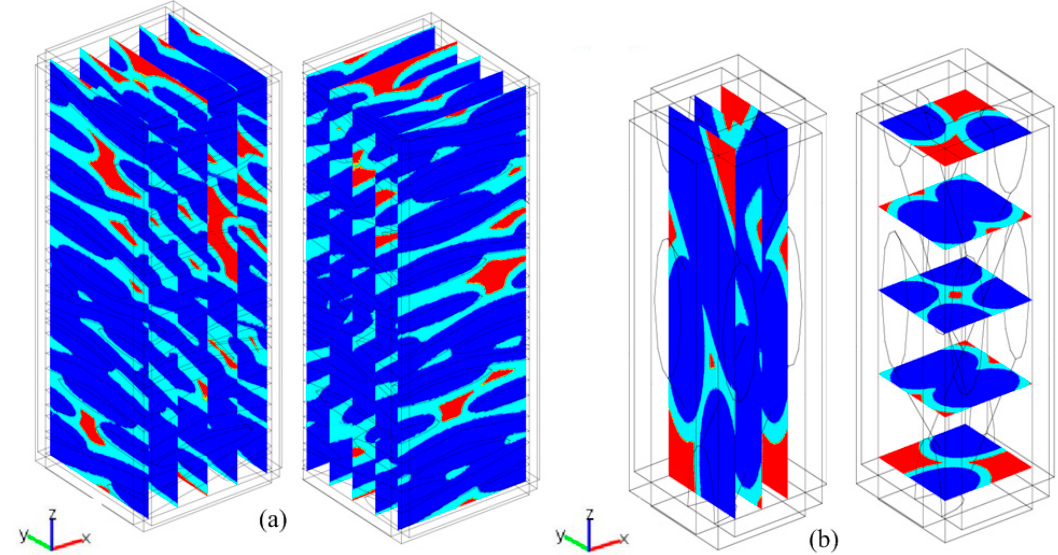
Figure 8. Illustration of the models for calculation of thermal conductivity of ( a ) 2D woven and ( b ) 3D braided fiber structures.